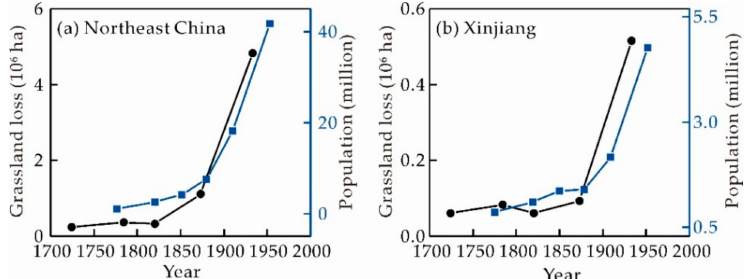
Figure 9. Population and grassland losses for the period between 1776 and 1953 reconstructed using PENG and CHCD for ( a ) northeastern China and ( b ) Xinjiang. Human population data were sourced from references